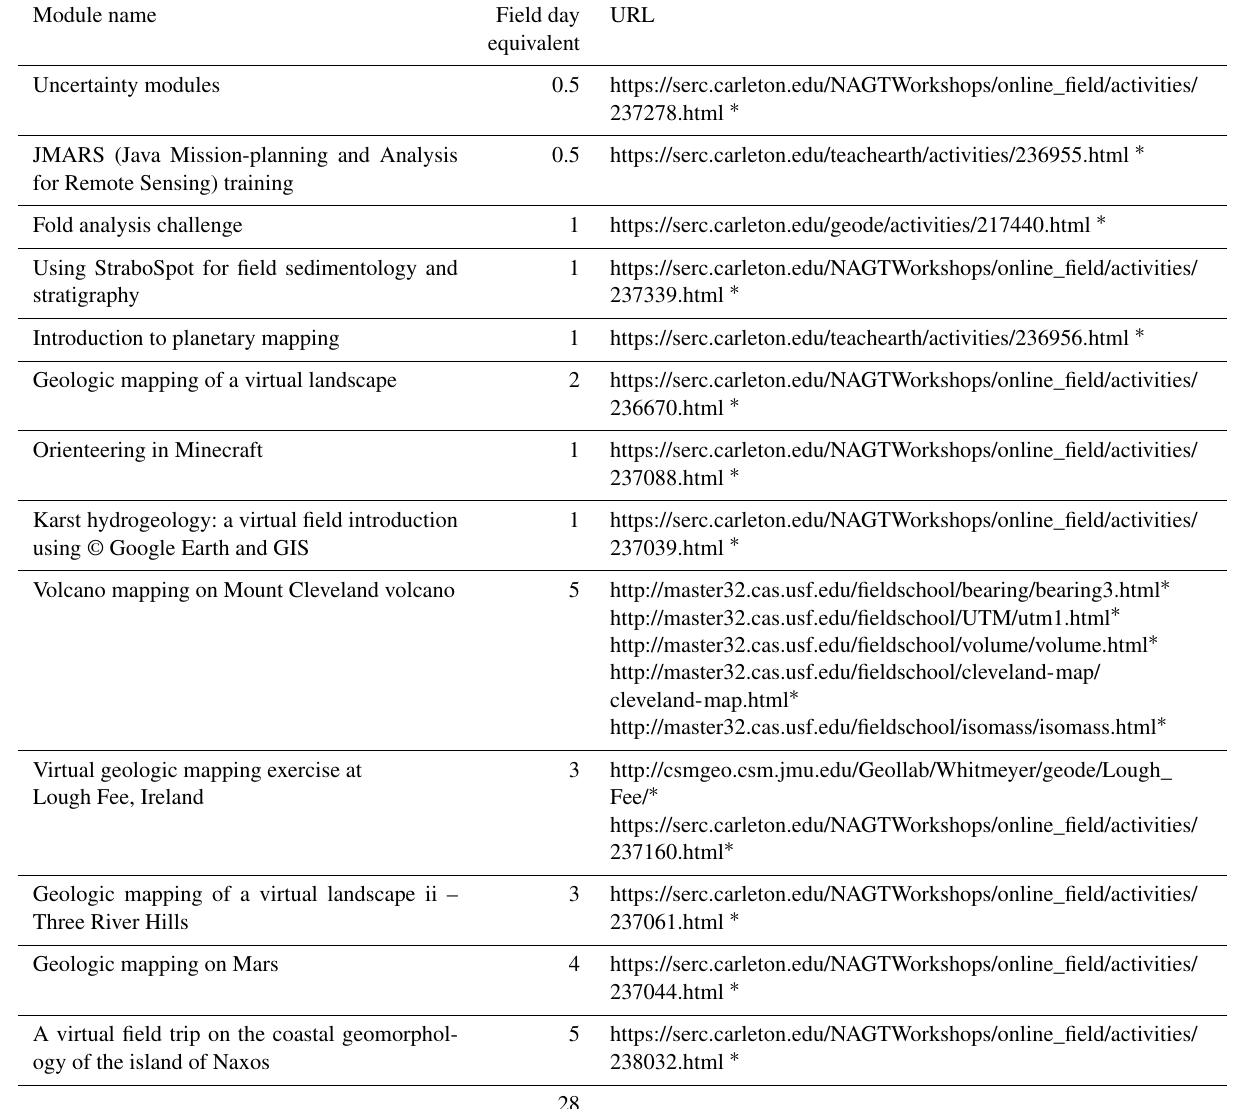
Table 2. Modules for planetary geology virtual capstone